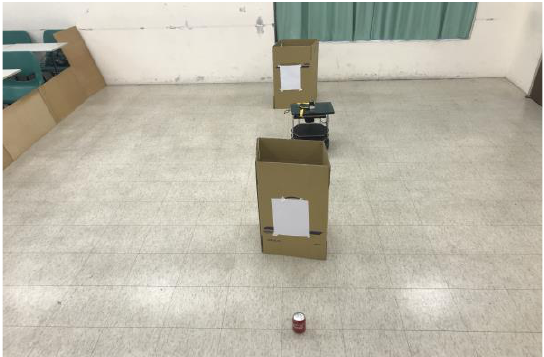
Figure 19. The Second arena of autonomous mobile robot navigation in a real-world experiment.